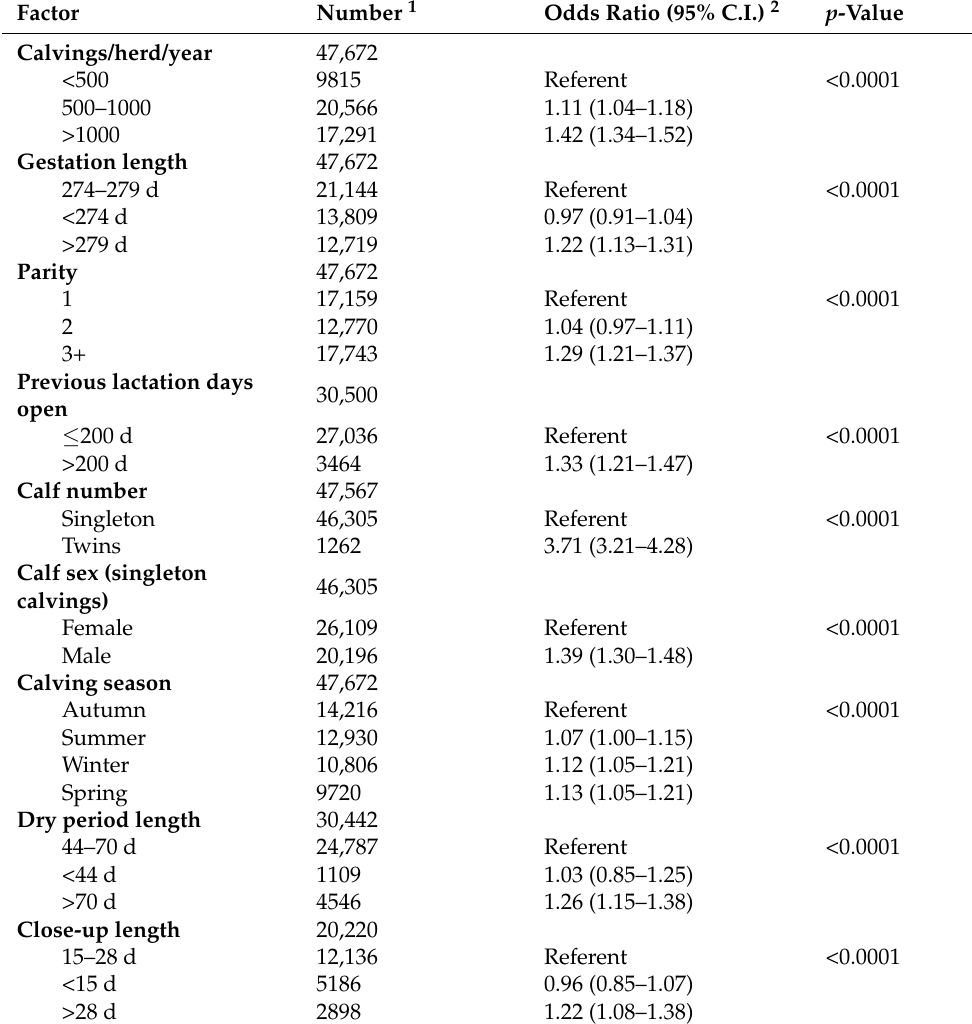
Table 3. Risk factor associations with calving ease.